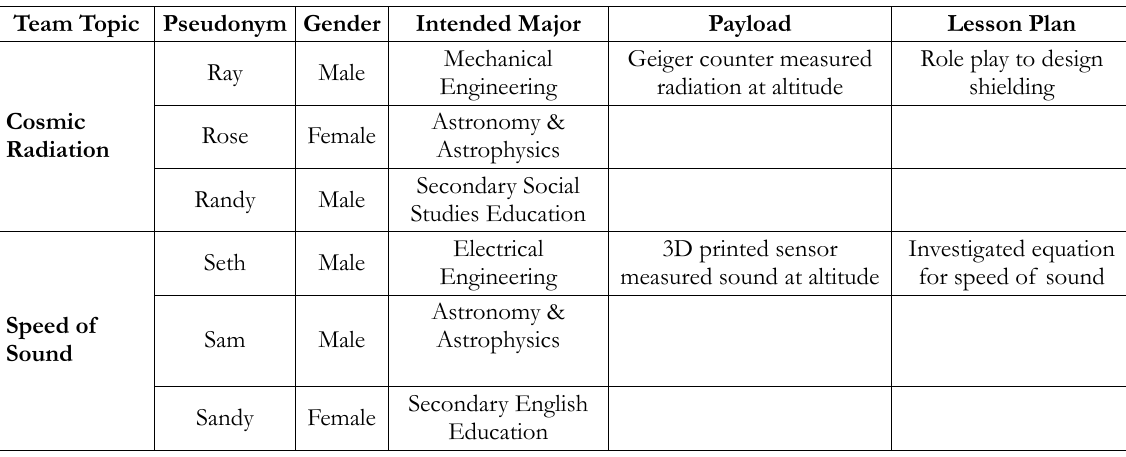
Table 1. Undergraduate college student participant